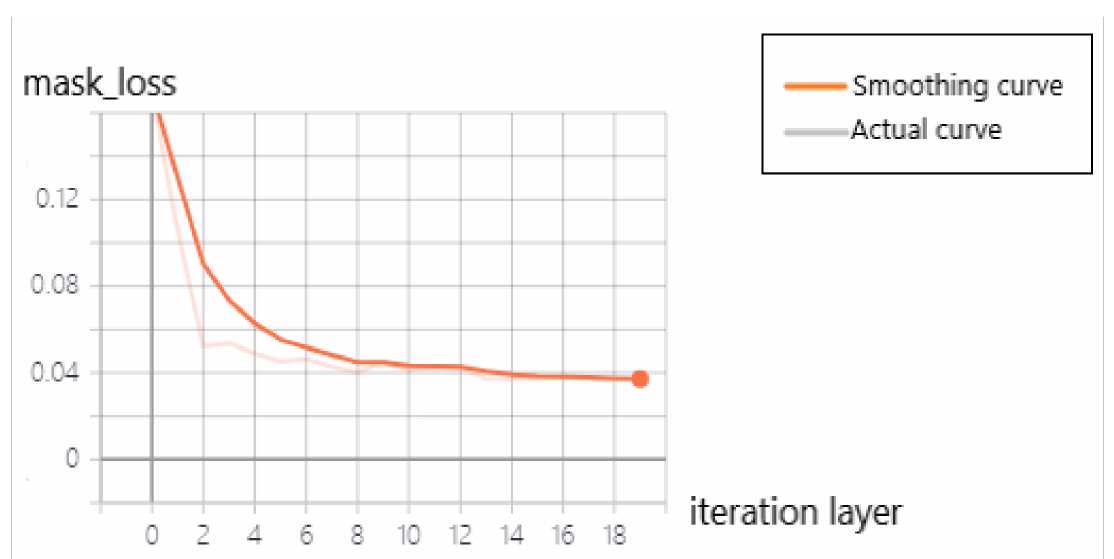
Figure 23. Mask loss of Mask R-CNN